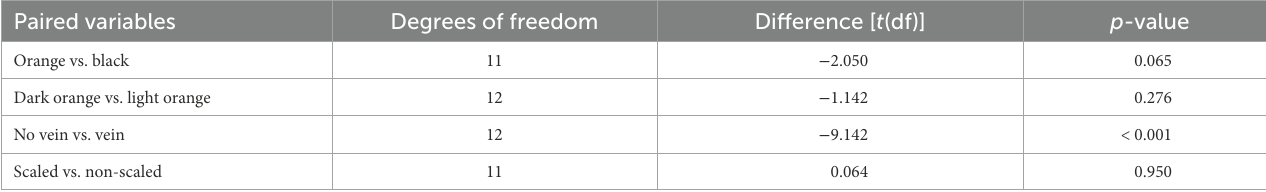
TABLE 3 Table showing the paired t -test results for intra-wing differences in δ 2 H of wing samples based on wing colour (orange vs. black), wing pigmentation (dark orange vs. light orange), vein vs. no vein in wing sample and scaled vs. non-scaled wing samples within an individual. Paired variables Degrees of freedom Difference [ t (df)] p -value Orange vs. black 11 − 2.050 Dark orange vs. light orange 12 − 1.142 No vein vs. vein 12 Scaled vs. non-scaled